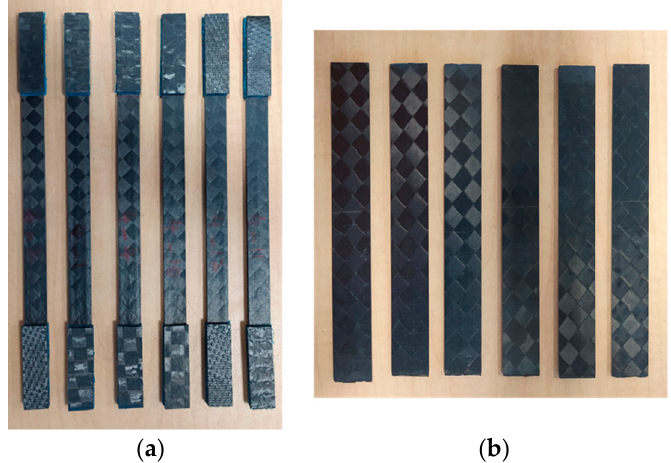
Figure 5. ( a ) Cut tensile specimens (TY1_A to TY6_A) ( b ) Cut bending specimens (TY1_B to TY6_B).